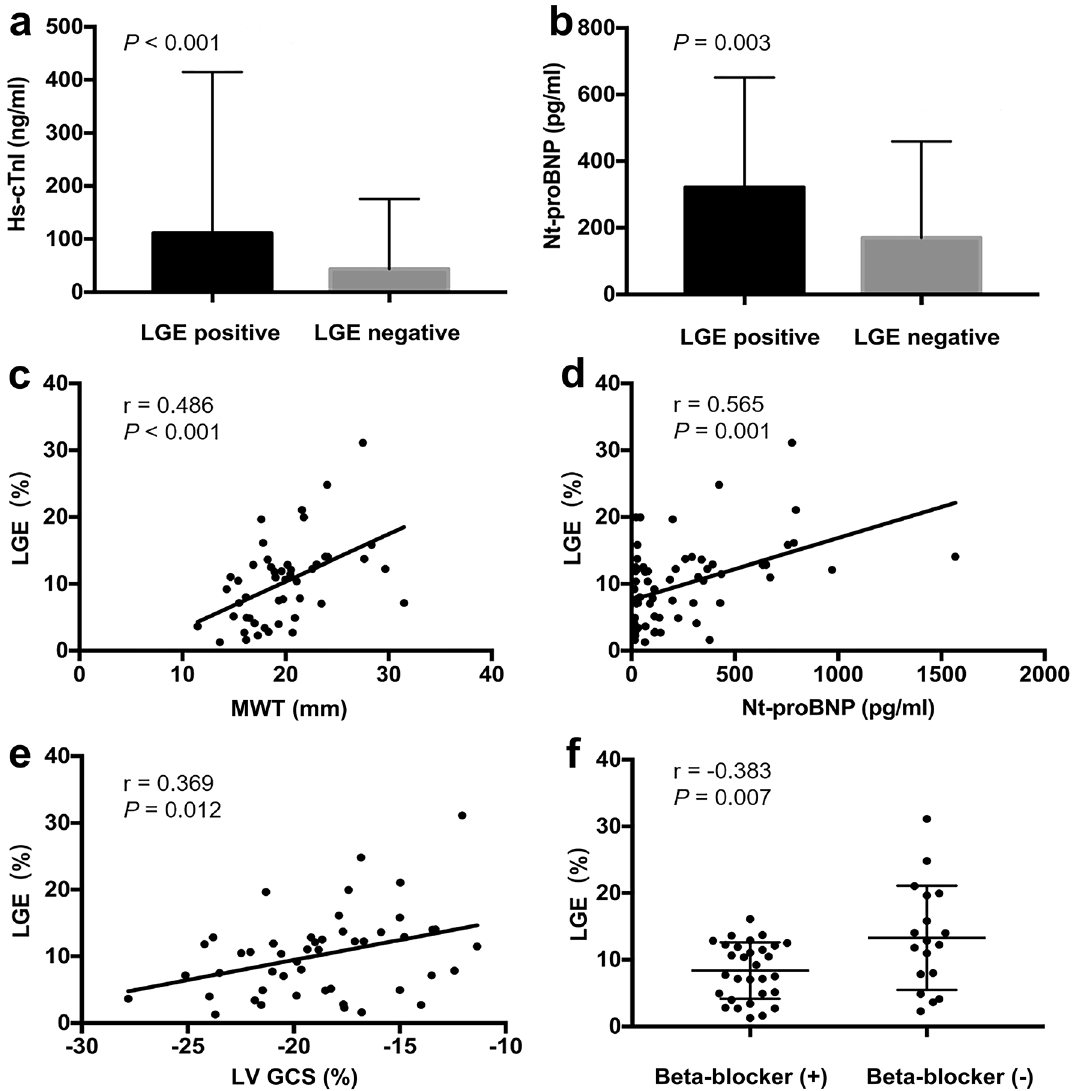
Figure 1. Comparison of the mean serum hs-cTnI ( a ) and Nt-proBNP ( b ) levels between LGE-positive and LGE-negative patients. Correlations between the LGE% and the MWT ( c ), Nt-proBNP ( d ), GCS ( e ) and beta- blocker treatment ( f ) in HCM patients. hs-cTnI high-sensitivity cardiac troponin I, Nt-proBNP N-terminal pro B-type natriuretic peptide, LGE late gadolinium enhancement, MWT maximum wall thickness, GCS global circumferential